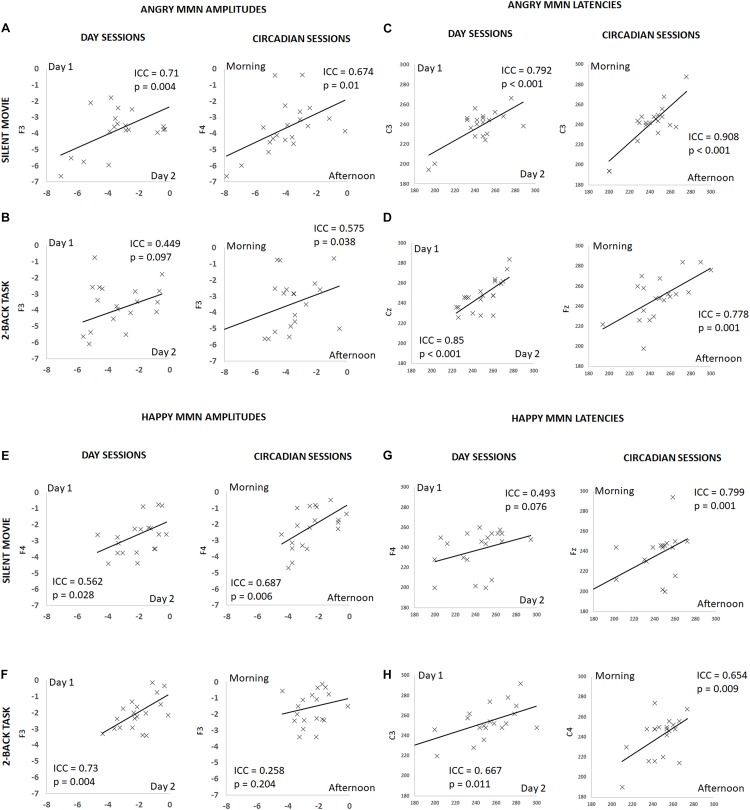
Summary of individual estimates for intraclass correlation coefficient (ICC) in amplitude and latency, for angry and happy MMN, on different days and at different times of a day, during the silent movie and 2-back working memory task conditions. X-axis denotes individual values in day 2 or afternoon session and Y-axis in day 1 or morning session. Plots show test–retest angry MMN amplitudes in the silent movie condition (A) and in the 2-back condition (B), test–retest angry MMN peak latencies in the silent movie condition (C) and in the 2-back condition (D), test–retest happy MMN amplitudes in the silent movie condition (E) and in the 2-back condition (F), and test–retest happy MMN peak latencies in the silent movie condition (G) and in the 2-back condition (H).